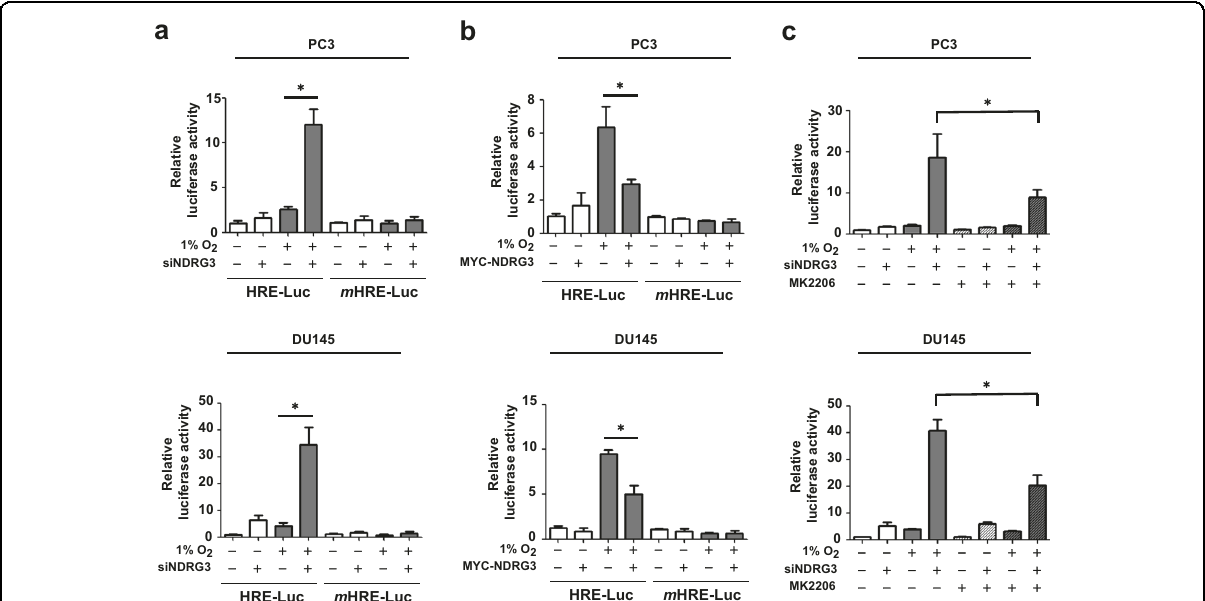
Fig. 4 NDRG3 attenuates HIF-1-mediated HRE activation under hypoxia. a PC3 and DU145 cells were co-transfected with the HRE- or mutated HRE-luciferase plasmid, the CMV- β -galactosidase plasmid, and siCtrl or siNDRG3, and incubated under normoxia or hypoxia for 24 h. b Cells were co- transfected with the reporter, the CMV- β -galactosidase, and pcDNA or MYC-NDRG3 plasmids, and incubated under normoxia or hypoxia for 24 h. c Cells were co-transfected with the HRE reporter plasmid, the β -galactosidase plasmid, and siCtrl or siNDRG3. The cells were treated with DMSO or MK- 2206 and incubated under normoxia or hypoxia for 24 h. Luciferase activities (means + s.d., n = 3) were normalized to β -galactosidase activities. * denotes P < 0.05 between the indicated